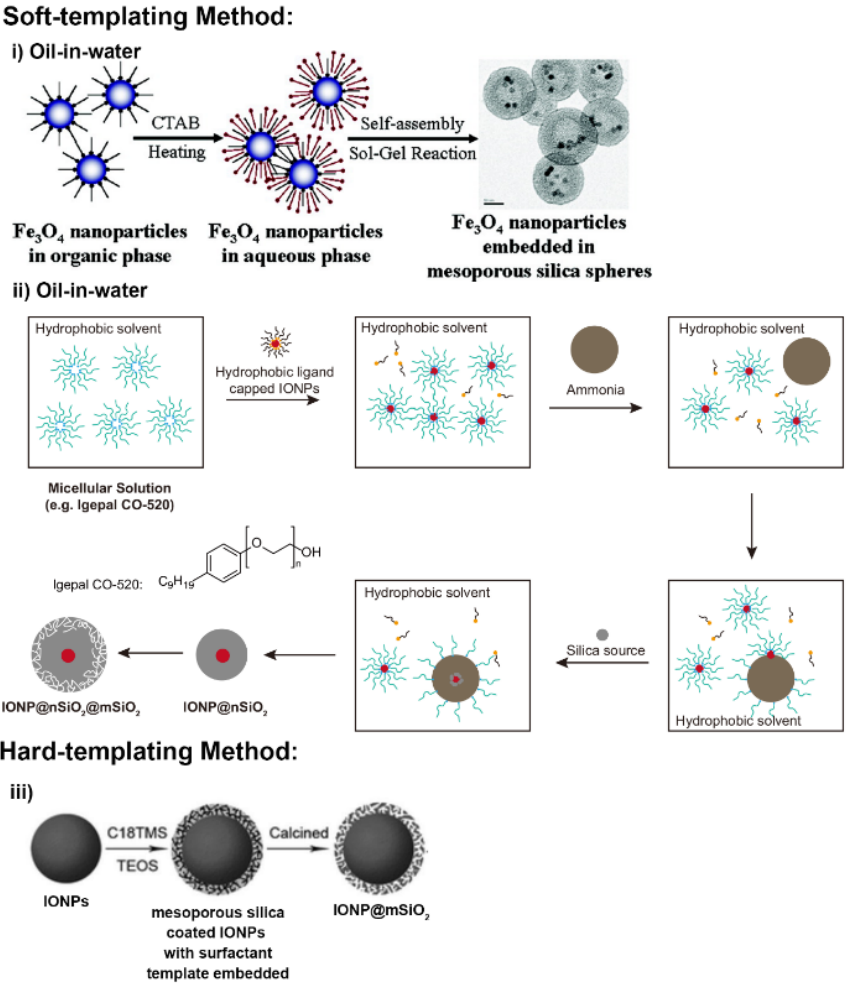
Figure 3. A schematic illustration of the synthesis of magnetic mesoporous silica nanoparticles